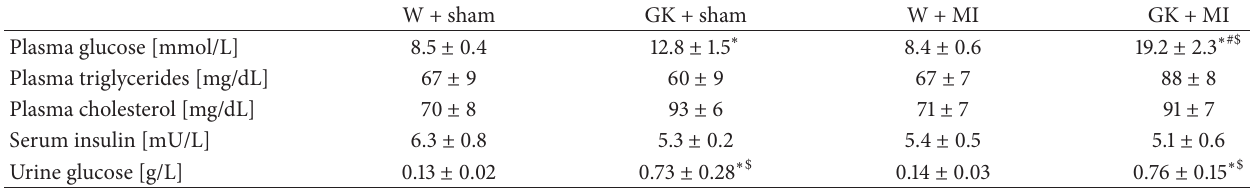
Table 2: Physiological characteristics of Goto-Kakizaki (GK) and control rats 24 h after sham operation or myocardial infarction. W + sham GK + sham W + MI GK + MI Body weight [g] 450 ± 6 331 ± 8 ∗ $ 444 ± 11 322 ± 6 ∗ $ Heart weight to body weight ratio [ × 1,000] Heart rate [beats/min] 453 ± 13 454 ± 28 456 ± 6 453 ± 4 SBP [mmHg] 145 ± 6 123 ± 6 137 ± 8 120 ± 7 ∗ DBP [mmHg] 117 ± 5 89 ± 6 ∗ 113 ± 8 92 ± 8 ∗ MAP [mmHg] 126 ± 5 100 ± 6 ∗ 121 ± 8 102 ± 7 ∗ Data is expressed as mean ± SEM; ∗ 𝑃 < 0.05 versus W + sham; $ 𝑃 < 0.05 versus W + MI; MI indicates myocardial infarction; GK: Goto-Kakizaki; W: Wistar; SBP: systolic blood pressure; DBP: diastolic blood pressure; MAP: mean arterial